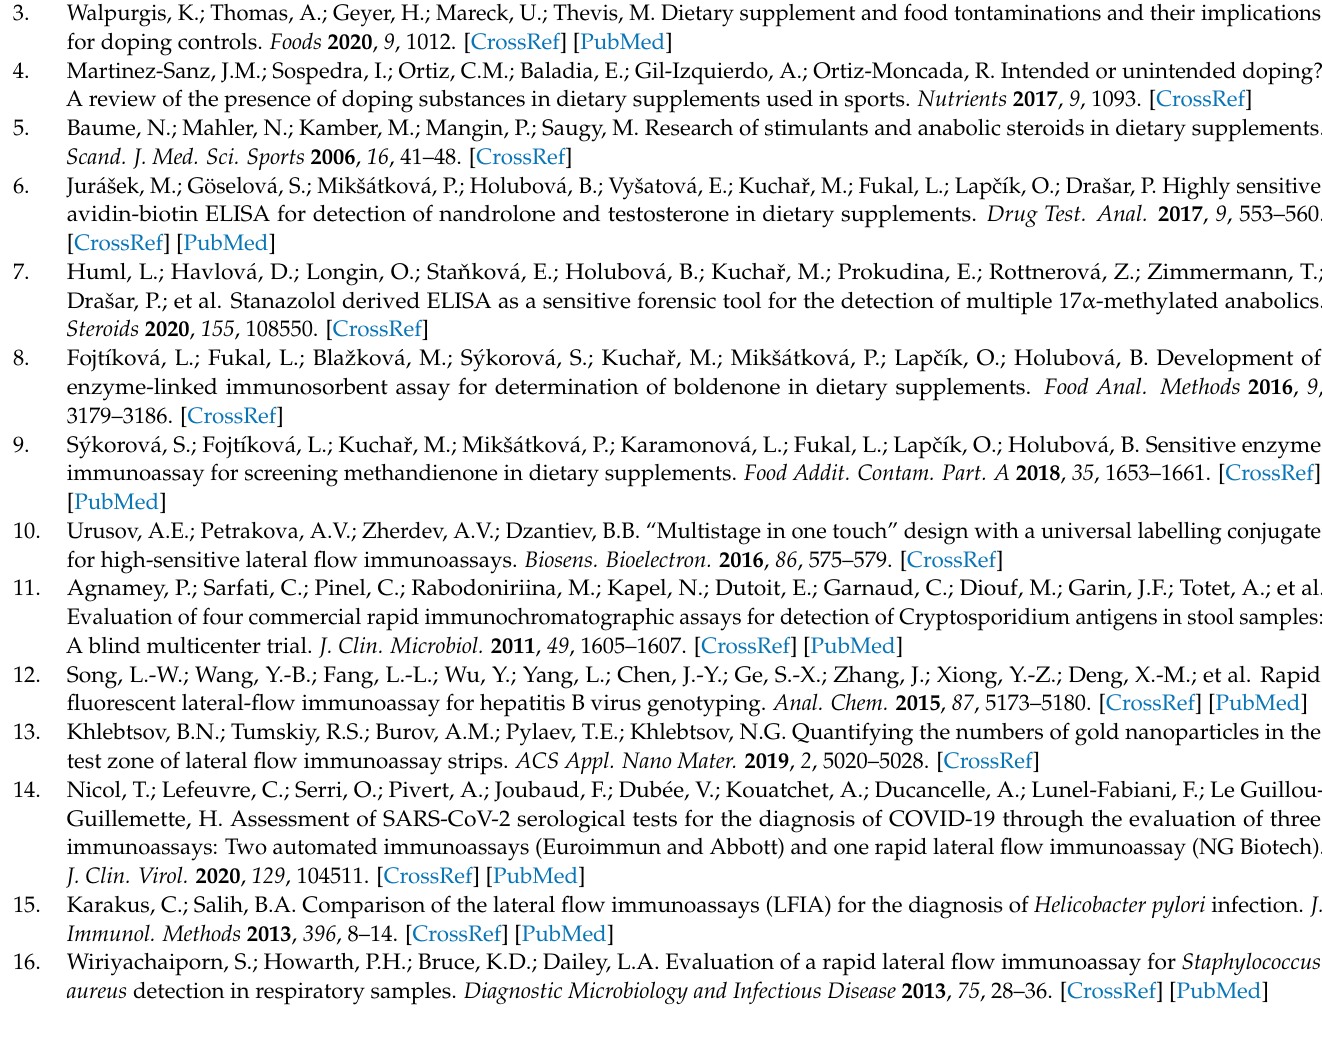
(1.5 µ L RAb-AuNPs were applied) on panel B, Figure S9: Tested amounts of applied RAb-AuNPs for closed format (panel A) and calibration series for direct closed format (3.5 µ L of RAb-AuNPs was applied; panel B), Figure S10: Testing of extraction solvent (panel A) and matrix effect (panel B) on the functionality of RAb 212 antibody, Table S4: Matrices used for contamination with AAS, Figure S11: Tested effect of selected matrices in indirect (panel A) and direct format (panel B) opened ICT format. The designation of the matrices is given above in Table S4, Figure S12: Tested selected matrices